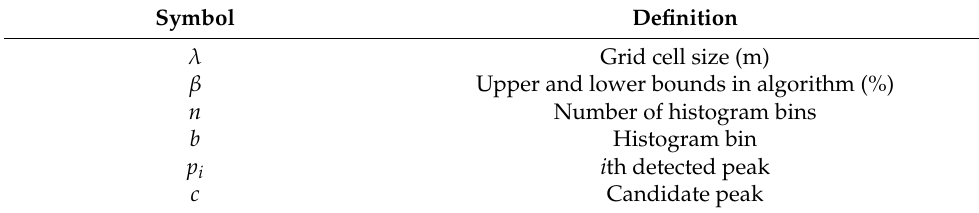
Table A1. Symbols used in the proposed